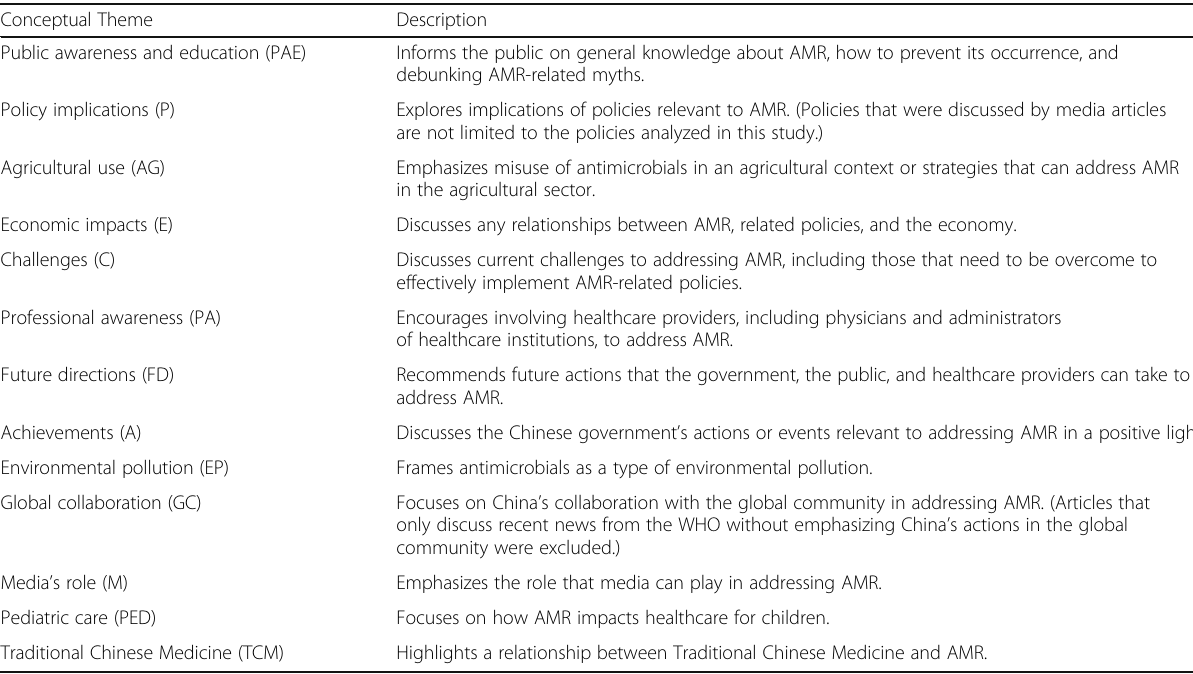
Table 1 Conceptual Themes, Ordered by Frequency of Appearance from Highest to